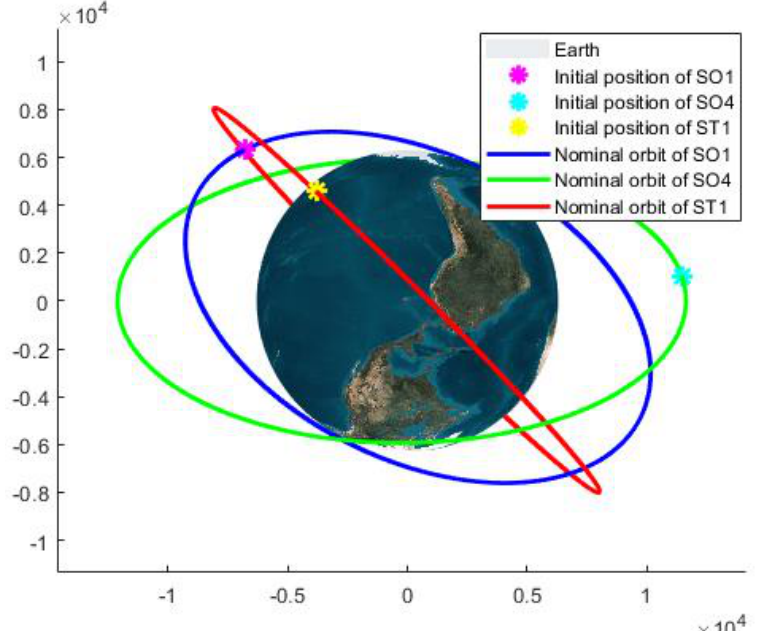
Figure 8. Orbits in general orbit configuration case with an additional observer.